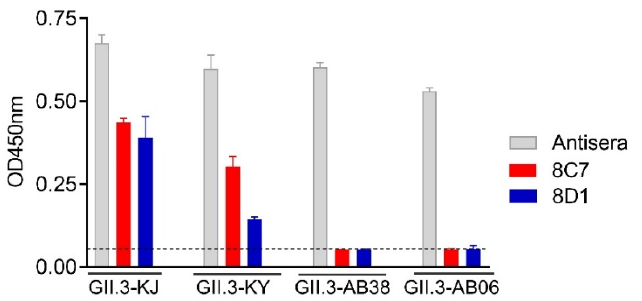
Figure 3. Cross-reactivity of the 8C7 and 8D1 mAbs was tested by ELISA with various wild-type GII.3 VLPs. Rabbit anti-GII.3 VLP antiserum was used as a positive control. Dashed line indicates the value from the blank well (containing no antigen). Data are mean ± SD of triplicate wells.